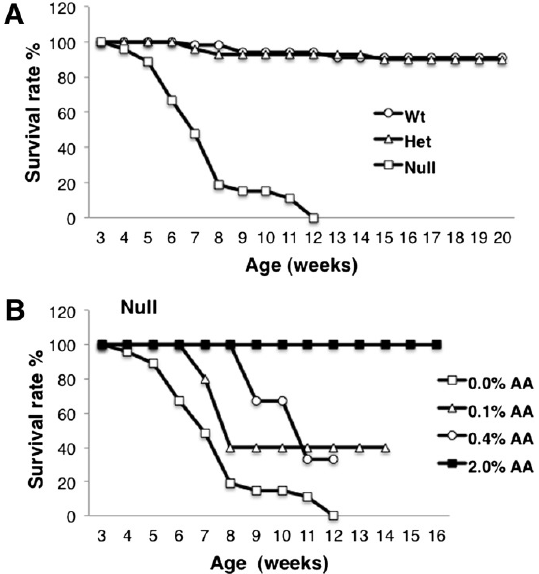
Figure 6. Kaplan ‐ Meier survival curves of Fads1 mice, AA = ARA. ( A ) Fads1 null mice exhibited low viability when fed a standard AA ‐ free diet; n = 37 for wild ‐ type, n = 44 for heterozygous, n = 11 for Null; ( B ) Dietary supplementation with AA (0.1% and 0.4%, w / w ) partially reversed the Fads1 null mouse phenotype; n = 5 for Null + 0.1% AA, n = 3 for Null + 0.4% AA. Supplementation with 2.0% AA completely reverse the Null phenotype; n = 4 for Null ± 2% AA (from Fan et al. [191]).